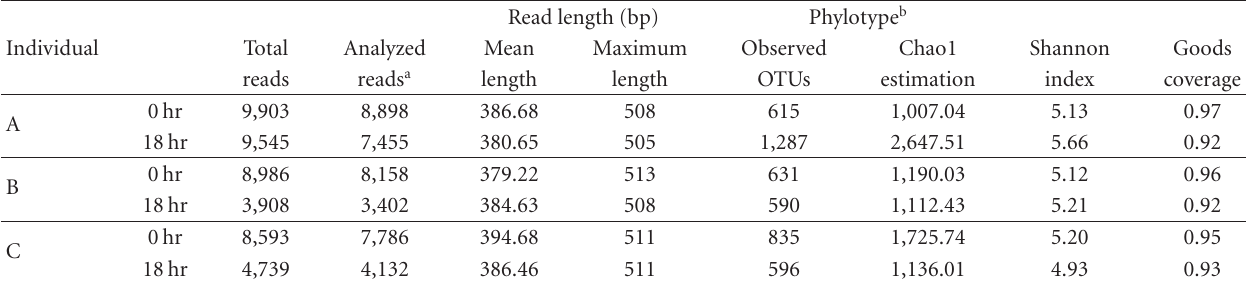
Table 4: The summary of pyrosequencing data and statistical calculations of fecal samples obtained from 3 individuals before and after 18 hours of incubation in low-carbohydrate